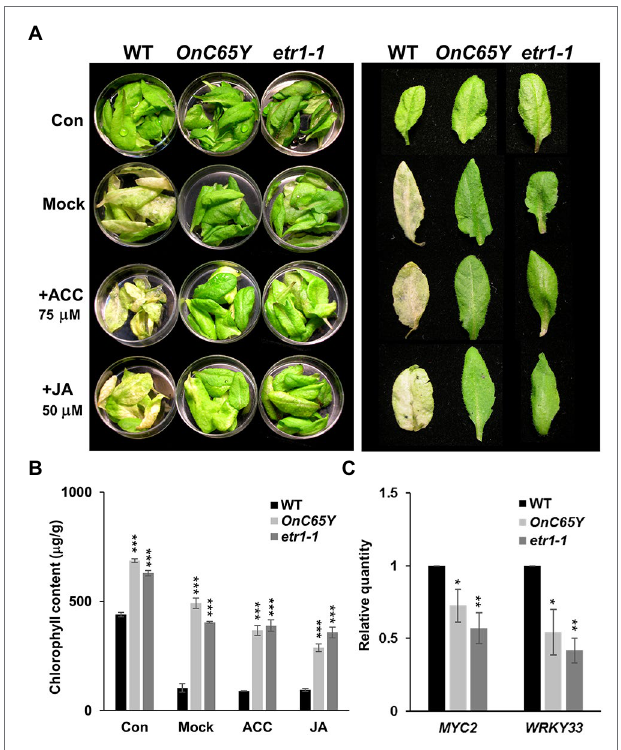
FIGURE 6 | Assay of the effect ACC and jasmonic acid (JA) treatments on detached leaf senescence in 35S:: OnETR1-C65Y and etr1-1 Arabidopsis . (A) Phenotypes of detached leaves from WT, 35S:: OnETR1 - C65Y ( OnC65Y ) and etr1 - 1 Arabidopsis treated with water (Mock), ACC or JA in the dark for 4 days. The control (con) did not receive a dark or ACC/JA treatment. The left panel shows the detached leaves in Petri dishes, whereas the right panel shows a single detached leaf. Detached wild-type leaves were clearly senescent, whereas detached 35S:: OnETR1 - C65Y and etr1 - 1 leaves were still green and showed no sign of senescence after ACC or JA treatment. (B) Measurement of the chlorophyll contents of the detached leaves from (A) . The error bars represent SD. The asterisks indicate a significant difference from the WT value (*** p < 0.001). Statistical analyses were conducted using two-tailed Student’s t -tests. (C) Detections of MYC2 and WRKY33 gene expression via real-time quantitative PCR. Total RNA isolated from 35S:: OnETR1-C65Y , etr1-1 and wild-type Arabidopsis was used as a template to detect the expression of MYC2 and WRKY33 . The transcript levels of these genes were determined using two to three replicates and were normalized to UBQ10 . The expression of each gene in the transgenic plants is given relative to that of the wild-type plant, which was set at 1. The error bars represent SDs. The asterisks indicate a significant difference from the WT value (* p < 0.05 and ** p < 0.01). Statistical analysis was conducting using two-tailed Student’s t 35S:: OnETR1-C65Y Inhibited Senescence by Suppressing MYC2 / WRKY33 in JA Signaling MYC2 and WRKY33 act as downstream genes in JA signaling and activate JA responses (Gfeller et al., 2010). Since 35S:: OnETR1 - C65Y and etr1-1 displayed inhibited senescence and JA insensitivity, an analysis of the expression of MYC2 and WRKY33 in 35S:: OnETR1 - C65Y and etr1-1 plants was performed. The results clearly indicated that MYC2 and WRKY33 expression was significantly downregulated in 35S:: OnETR1 - C65Y and